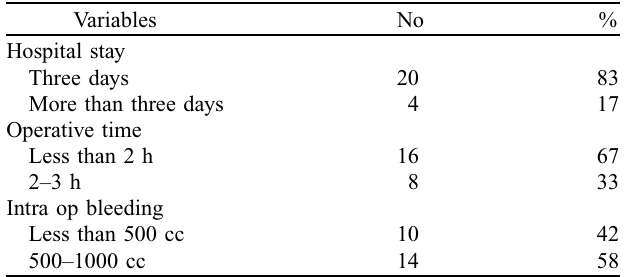
Table 2. Operative data and length of hospital